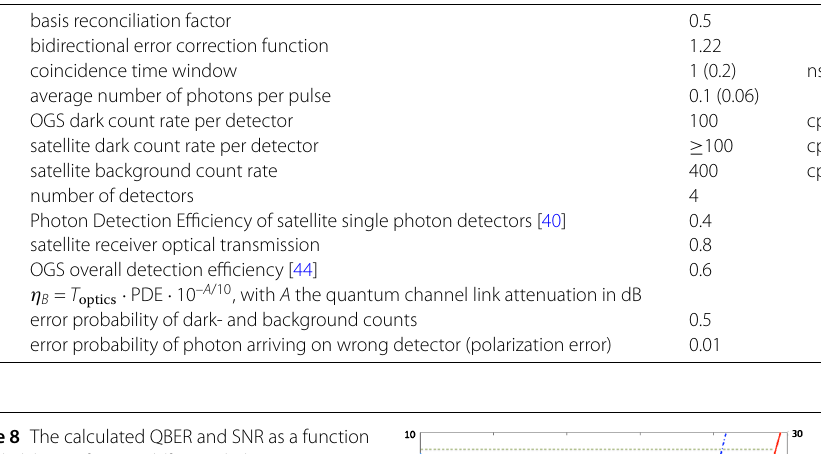
Figure 8 The calculated QBER and SNR as a function of the link losses for two different dark count rates (solid red curve: 100 cps; dotted blue curve: 1000 cps per detector). All other parameters are as in Table 3. No secret key distillation is possible if the QBER exceeds 9.4% (SNR > 9.6) for the case that the bidirectional error correction efficiency f equals 1.22 (dashed horizontal green line). The corresponding SNR is shown on the right y -axis (solid purple: 100 cps; dashed light blue: 1000 cps dark count